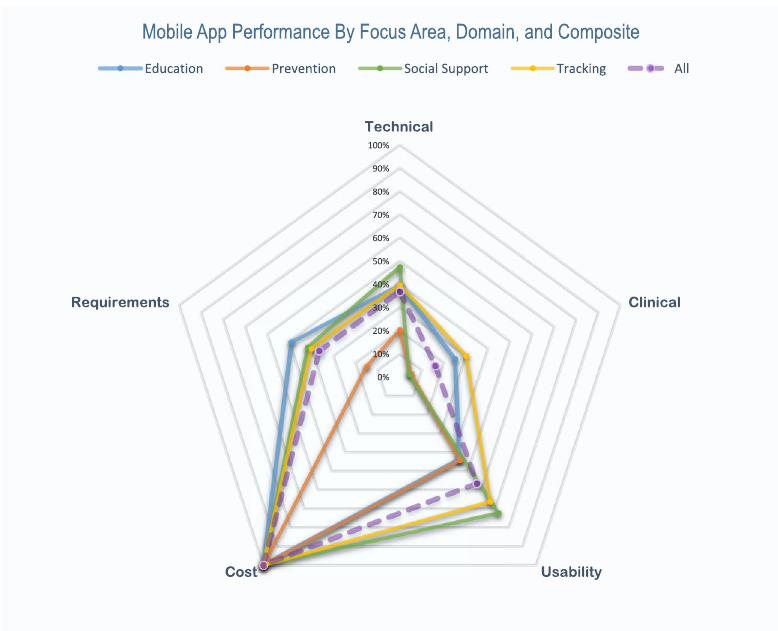
Fig. 4 Mobile app performance by focus area, domain, and composite. Distance from center to each point of the pentagon indicates performance in each respective domain domain. Colors represent app focus areas and dashed purple line represents composite performance of all